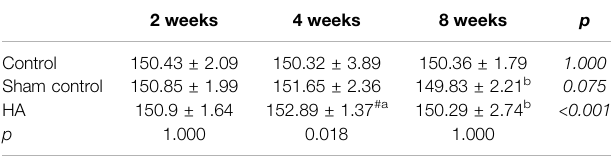
TABLE 1 | Quantitative analysis of VEGF expression at different time